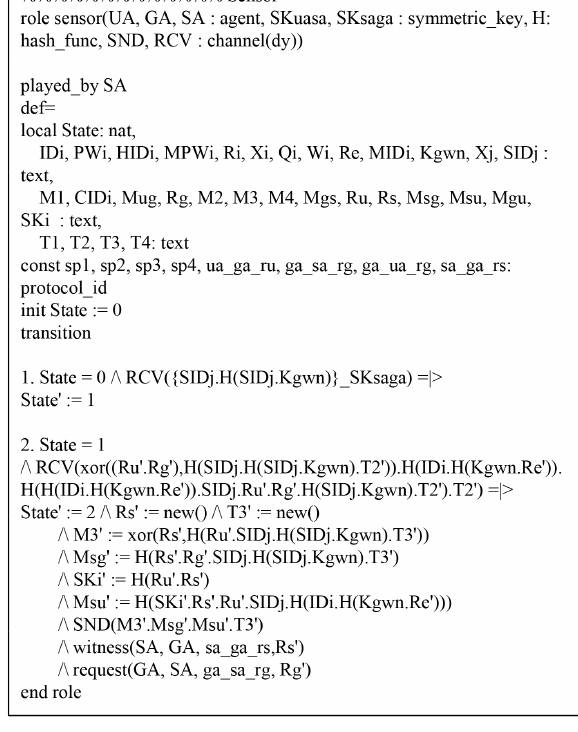
Figure 10. HLPSL syntax for S j .